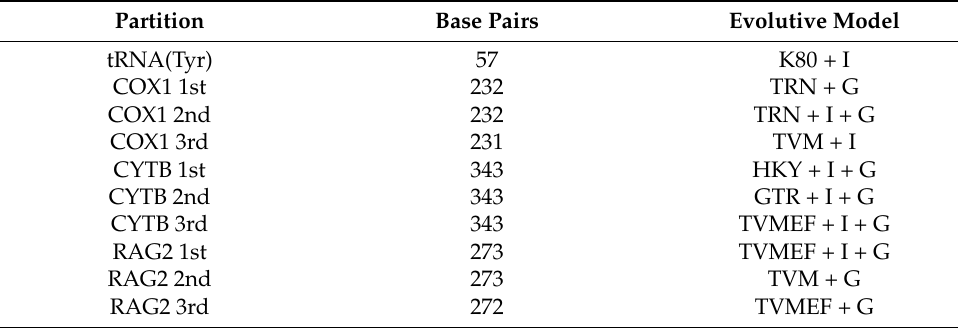
Table A2. Best-fitting partition schemes and evolutive